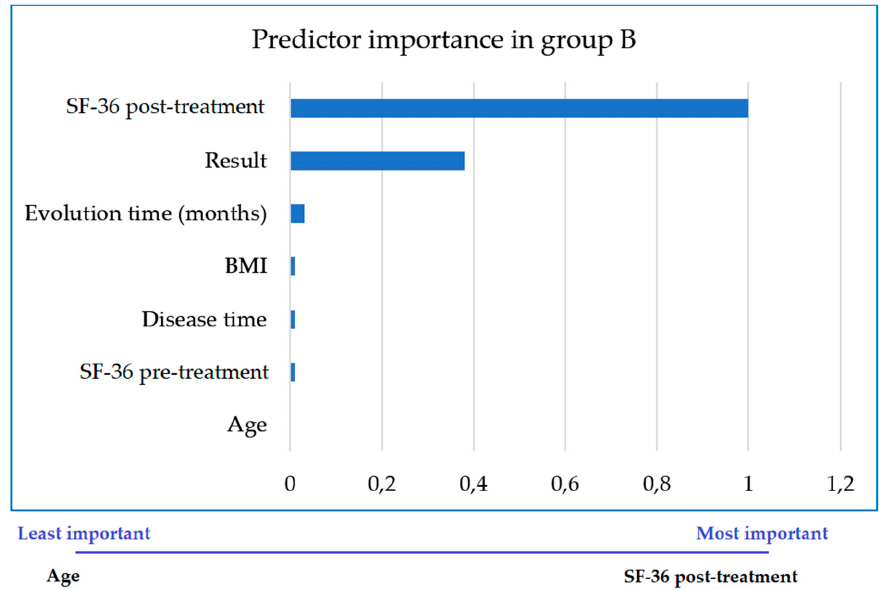
Figure 3. Importance of each variable as a predictor of the successful outcome of treatment in improving quality of life in women not treated with pelvic floor biofeedback (GB).